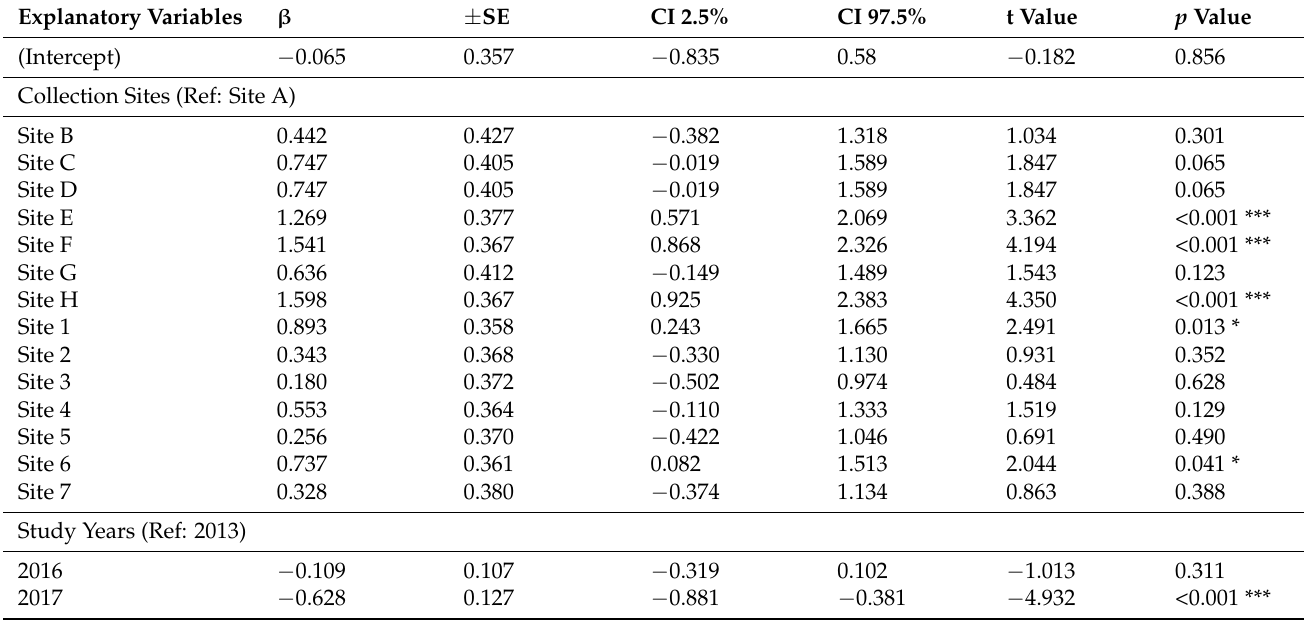
Table 2. Generalized linear model (GLM) results showing how collection site and year influenced the effective number of species (ENS).